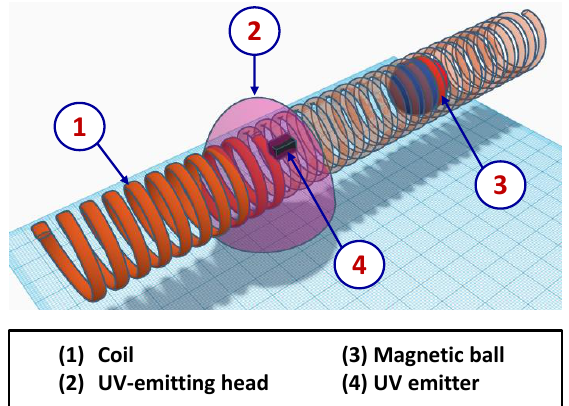
Figure 2. Basis of the motion power generation system.